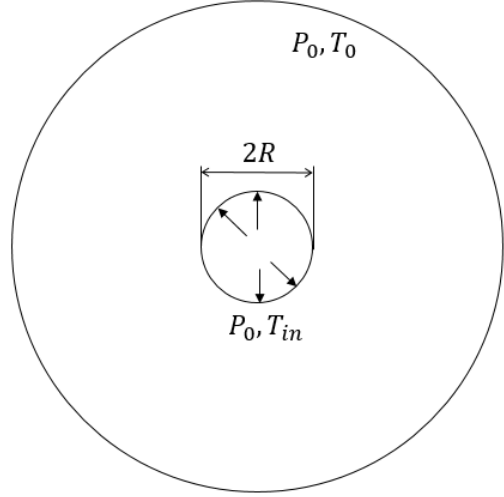
Figure 4. Geometry of the thermal consolidation THM